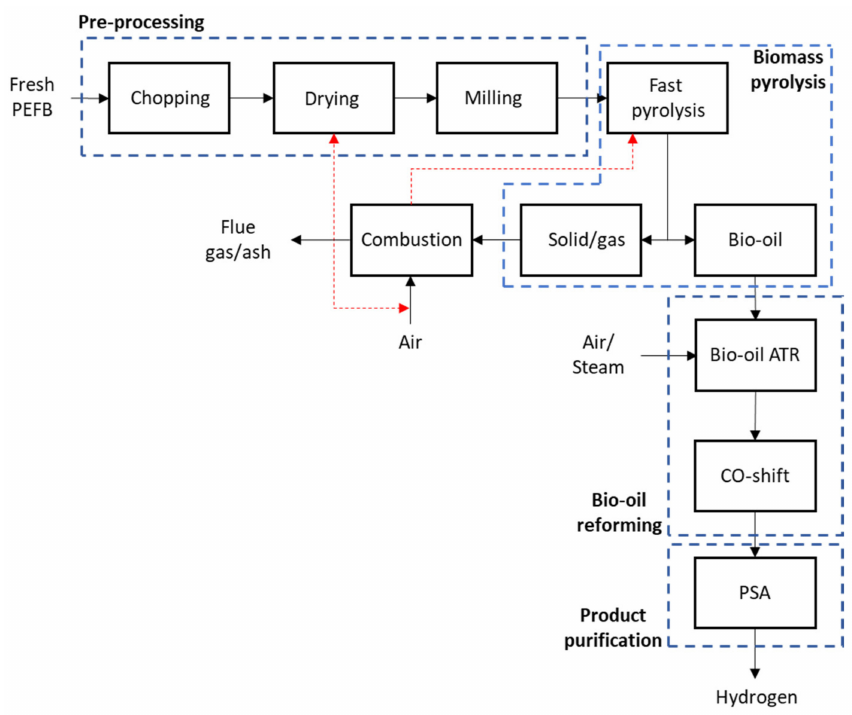
Figure 1. Process flow diagram for hydrogen production from 40 wt.% moist PEFB biomass. A pressure swing adsorption (PSA) unit is used to purify the syngas leaving the shift reactor. The hot syngas is cooled down to 30 ◦ C to condense and remove